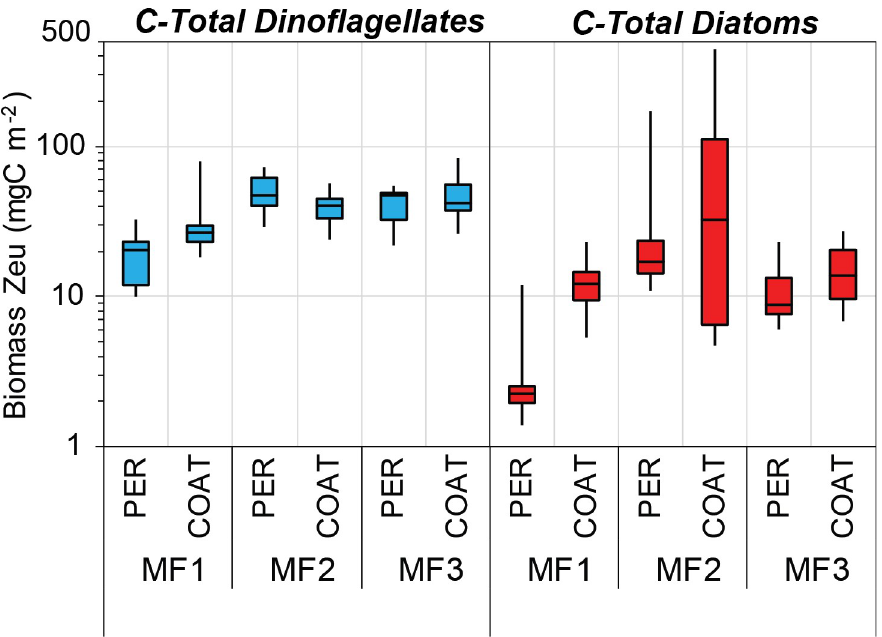
Fig 10. Depth-integrated per-cruise carbon biomass (mg C m -2 ) of total dinoflagellates and diatoms. Median values of integrated carbon biomass (mg C m -2 ) of total dinoflagellates (blue box-plots) and diatoms (red box-plots) in the euphotic zone (surface to ~150 m depth) at the Perdido (PER) and Coatzacoalcos (COAT) regions during MF1 (late winter 2016), MF2 (late summer 2016), and MF3 (spring 2018) cruises. The rectangular box represents the middle 50% of the data for each group, delimited by the lower quartile (Q1) and upper quartile (Q3). The median is represented by a straight line inside the box. Whiskers are drawn for the minimum and maximum values. Y-axis is logarithmically